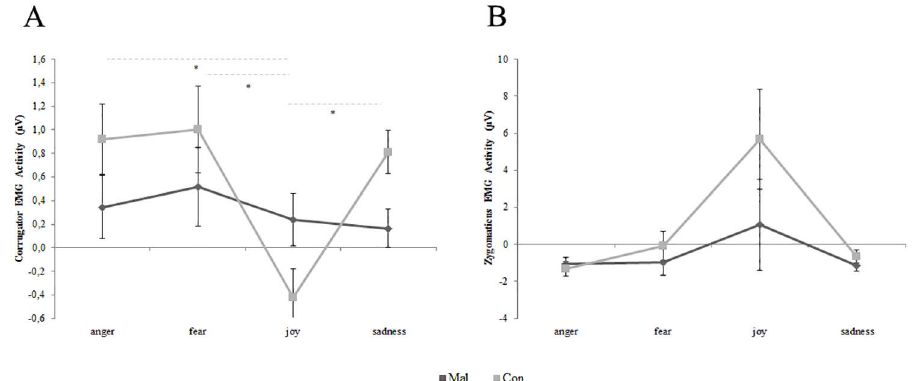
group (Con). * = p < 0.05. Error bars represent SE. B) Zygomaticus EMG activity displayedemotion by emotion for maltreated group (Mal) and control